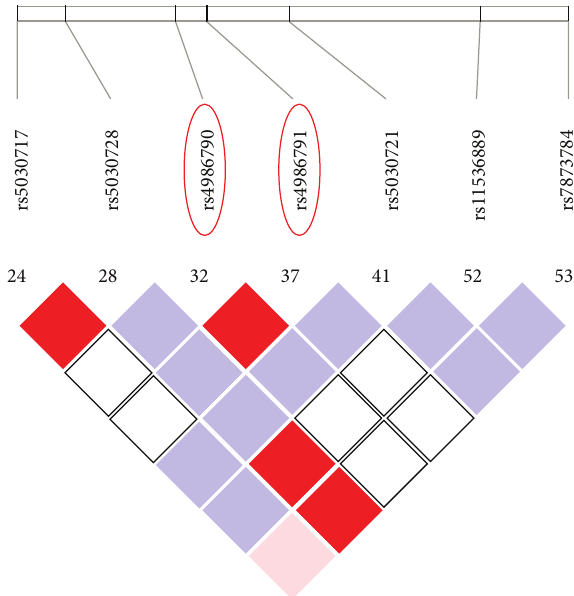
Figure 1: Schematic diagram of the position of TLR4 gene (rs4986790A > G and rs4986791C >